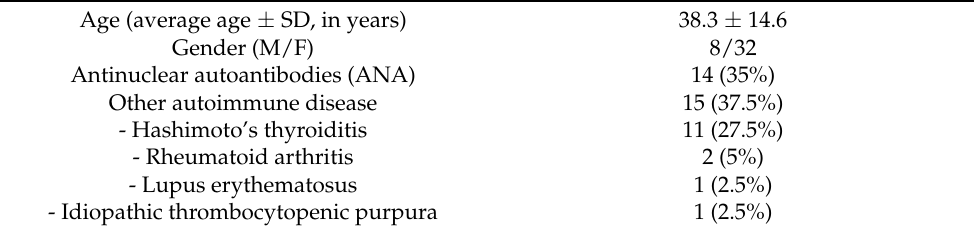
Table 2. Demographic data, laboratory findings (ANA) and coexisted autoimmune diseases in patients with autoimmune hearing loss and carriers of HLA B27, B35, B51, C4, C7, and DRB1*04 alleles ( n = 40